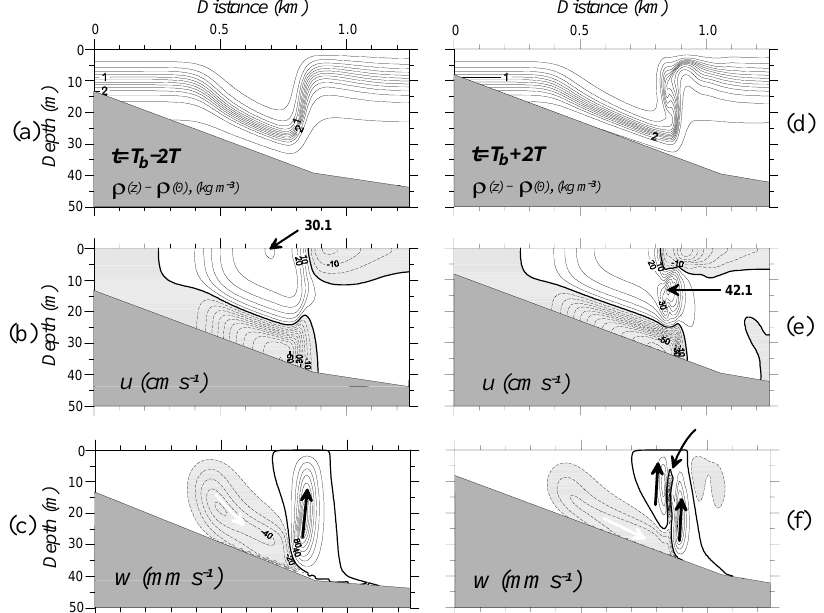
Fig. 9. Evolution of the density field (upper panels), horizontal velocity u (middle panels) and vertical velocity w (lower panels) during the breaking of the internal solitary wave. The left column ( (a)–(c) ) represents the wave field before breaking, and the right column ( (d)–(f) ) that after overturning. The time scale T equals 83s. Black and white arrows show the downward and upward water fluxes, the curved arrow shows the downward water flux at the site of wave breaking.